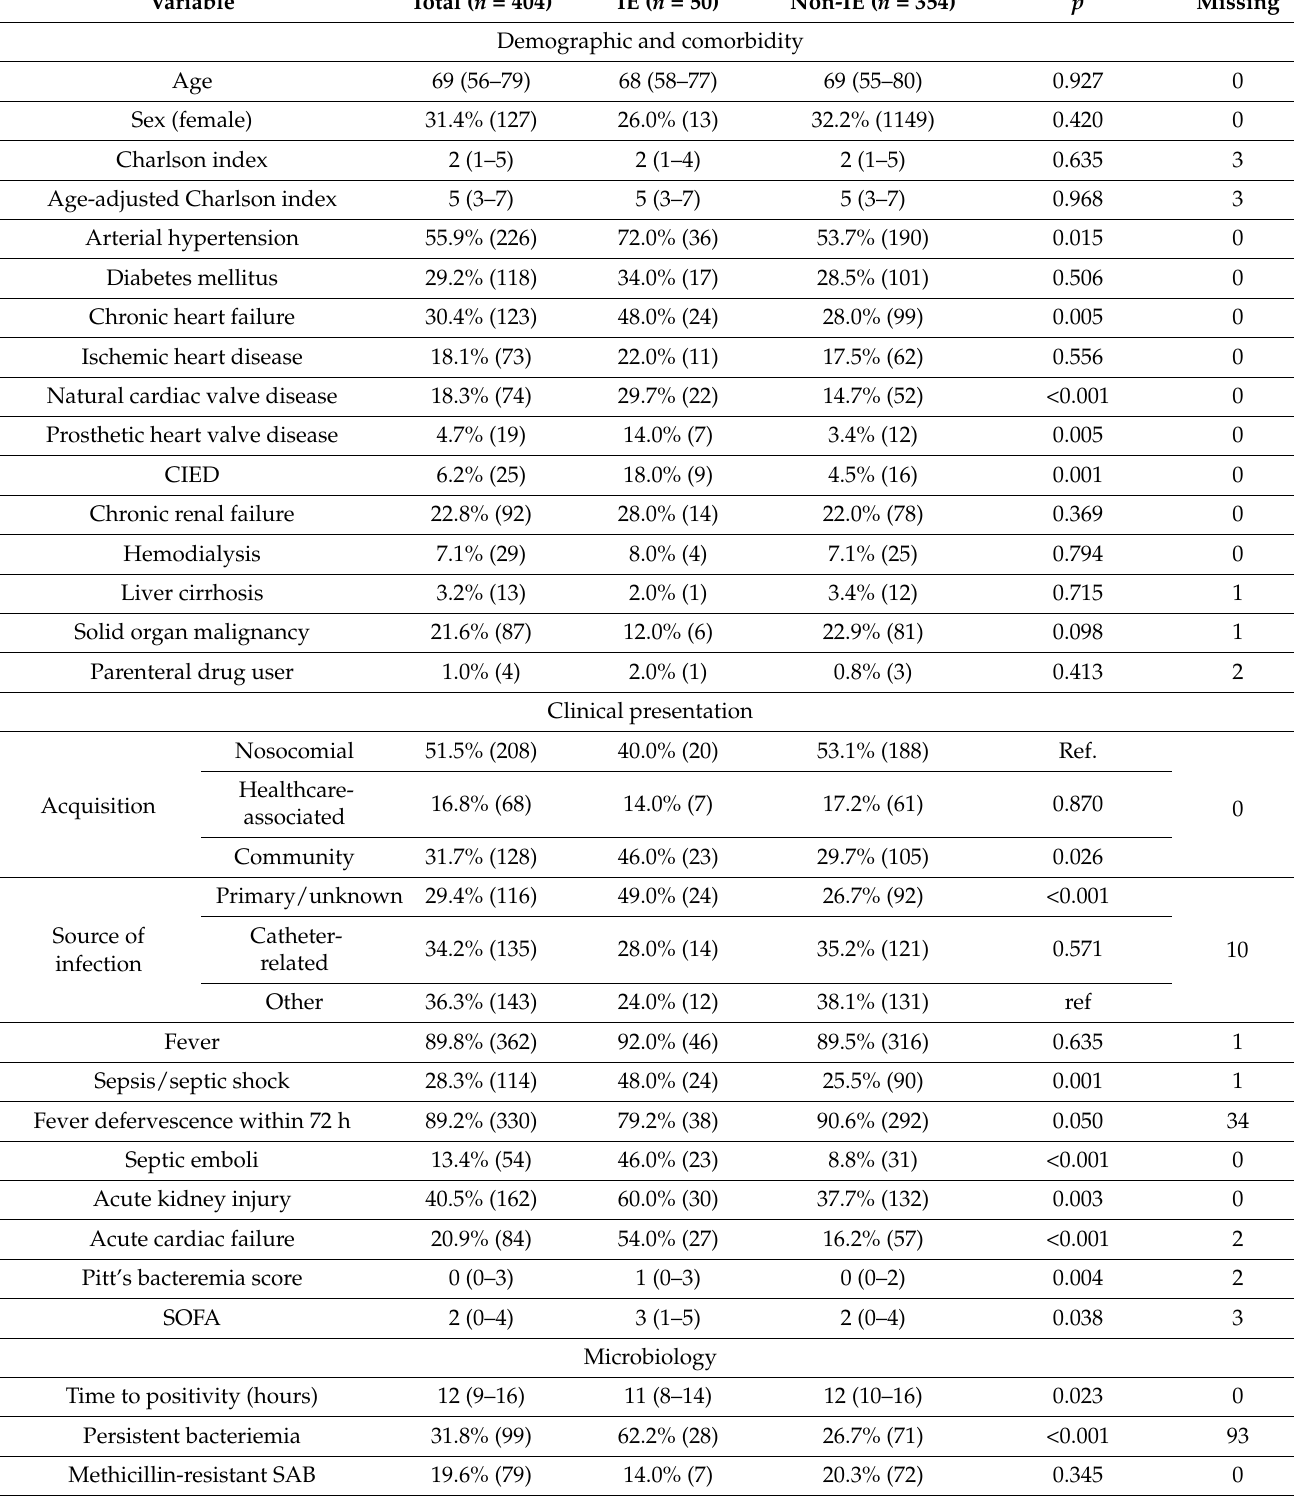
Table 1. Factors associated with IE in patients with